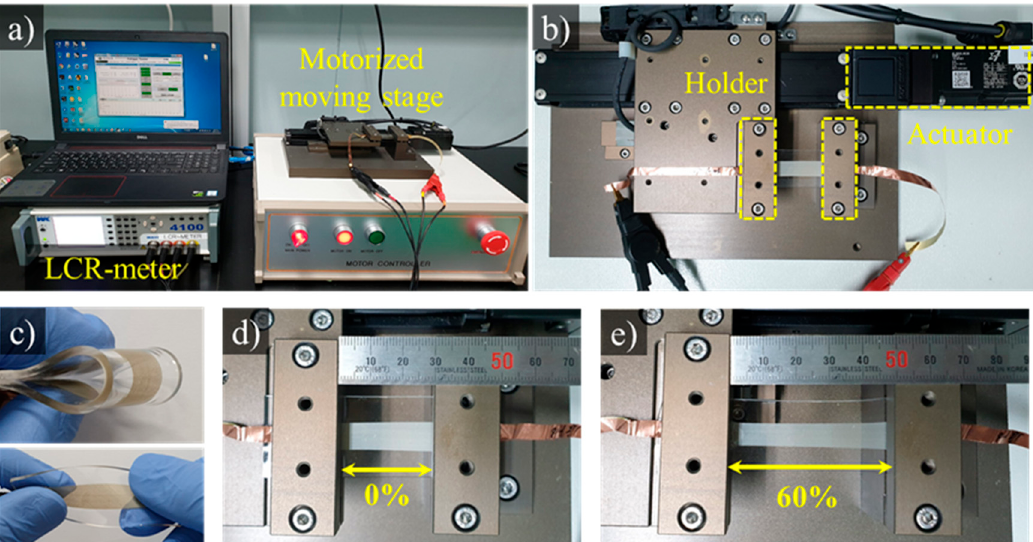
Figure 5. Configuration of test equipment. ( a ) Tensile test machine. ( b ) Motorized moving stage. ( c ) Fabricated sensors. ( d ) Fabricated sensors fixed to the motorized moving stage. ( e ) Stretching the sensor by 60%.